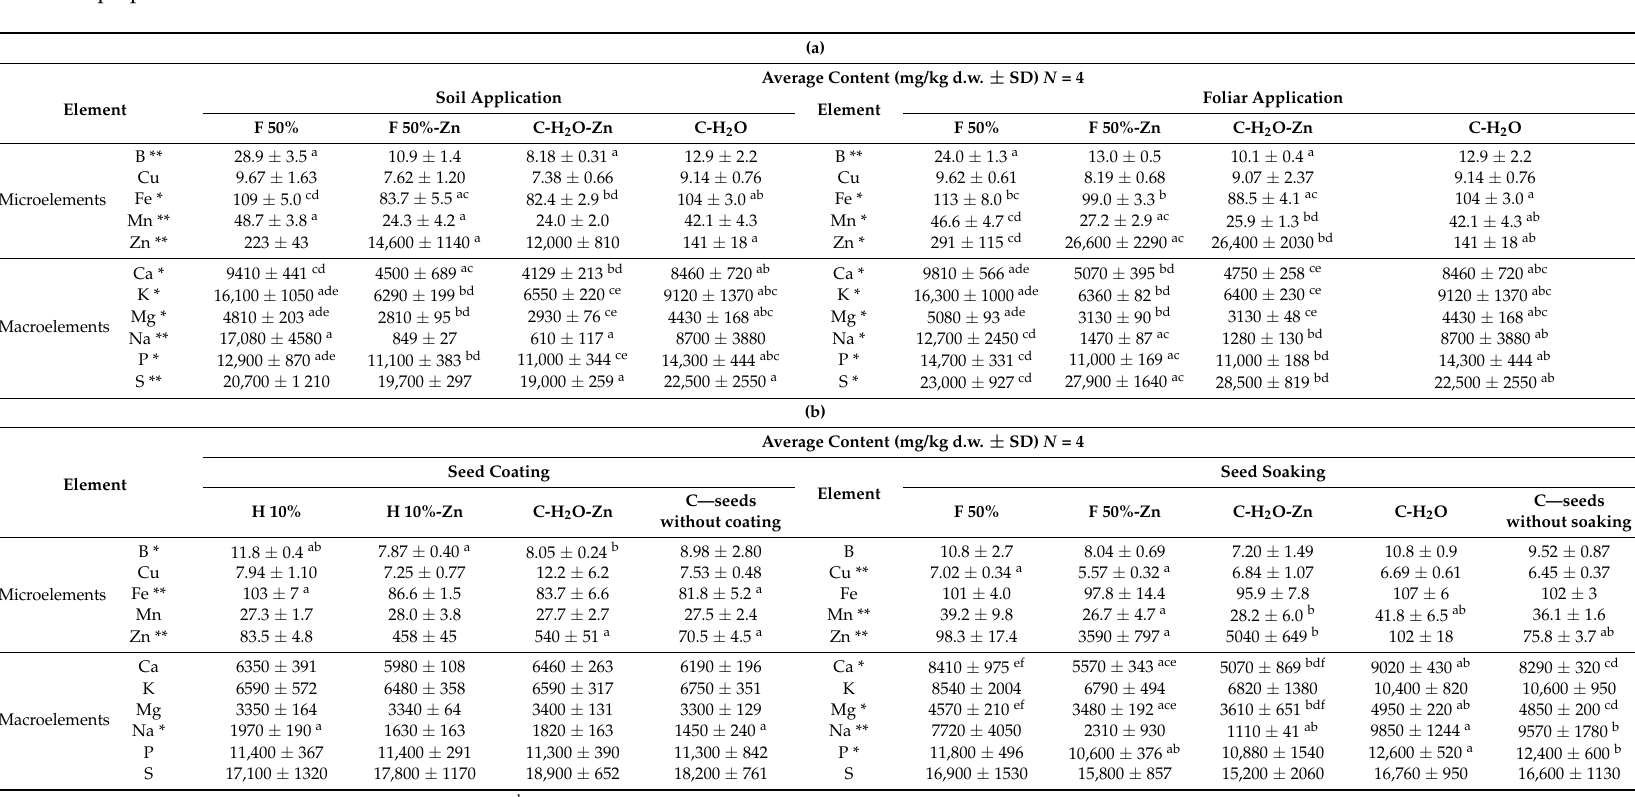
Table 6. Multi-elemental composition of the cultivated radish—( a ) after soil and foliar application of tested preparations; and ( b ) grown from coated and soaked seeds in tested